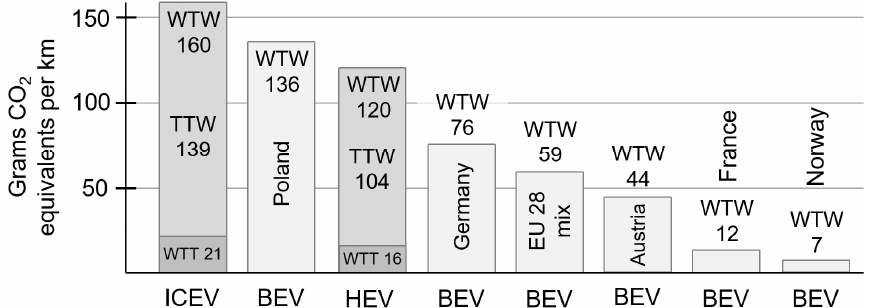
Figure 15. Well-to-wheel CO 2 -equivalent emissions of selected compact cars with different propulsion systems and varied carbon footprint of electricity production.